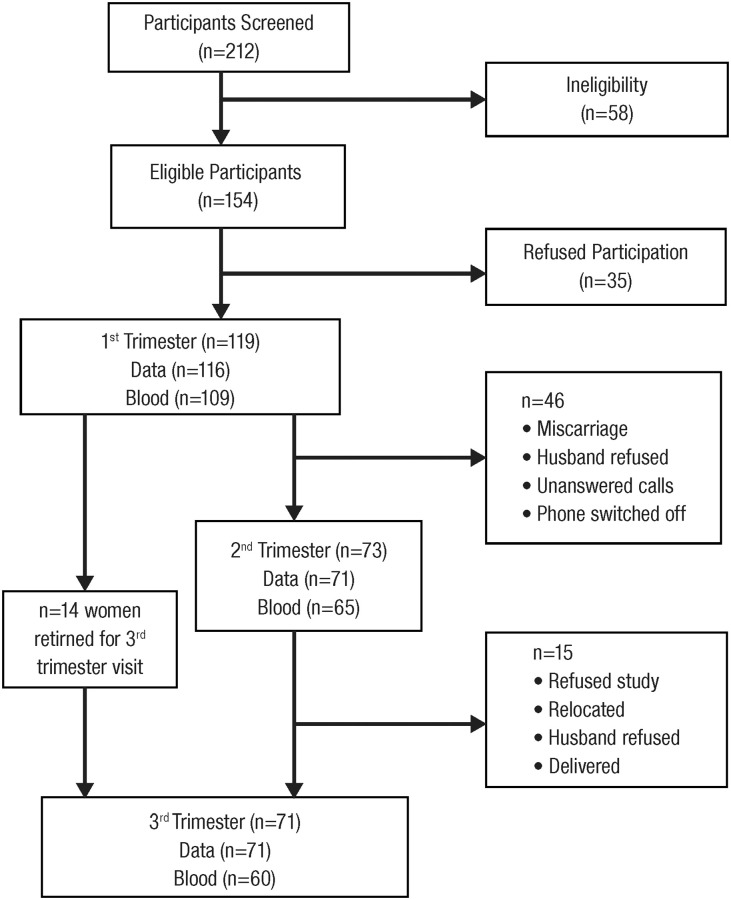
Participant flow chart by trimester.